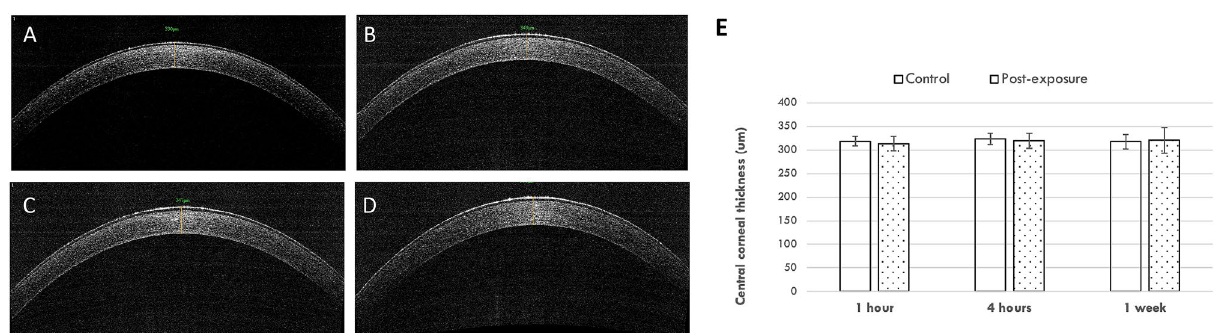
Figure 3. Representative ASCOT pictures for the control ( A ), 1 h ( B ), 4 h ( C ) and 1 week after 4 h-exposure groups ( D ). The bar graph showed that the CCT was at a consistent level over time after exposure ( E ). Error bars represent standard